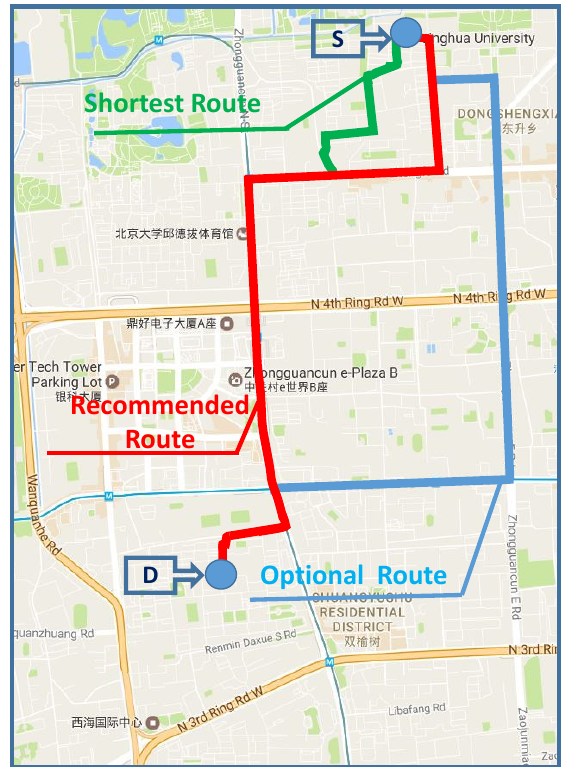
Figure 13. Illustration of the chosen routes when the initial battery SOC is 0.3. Table 5. The energy consumption and travel expense when the initial battery SOC is 0.3.